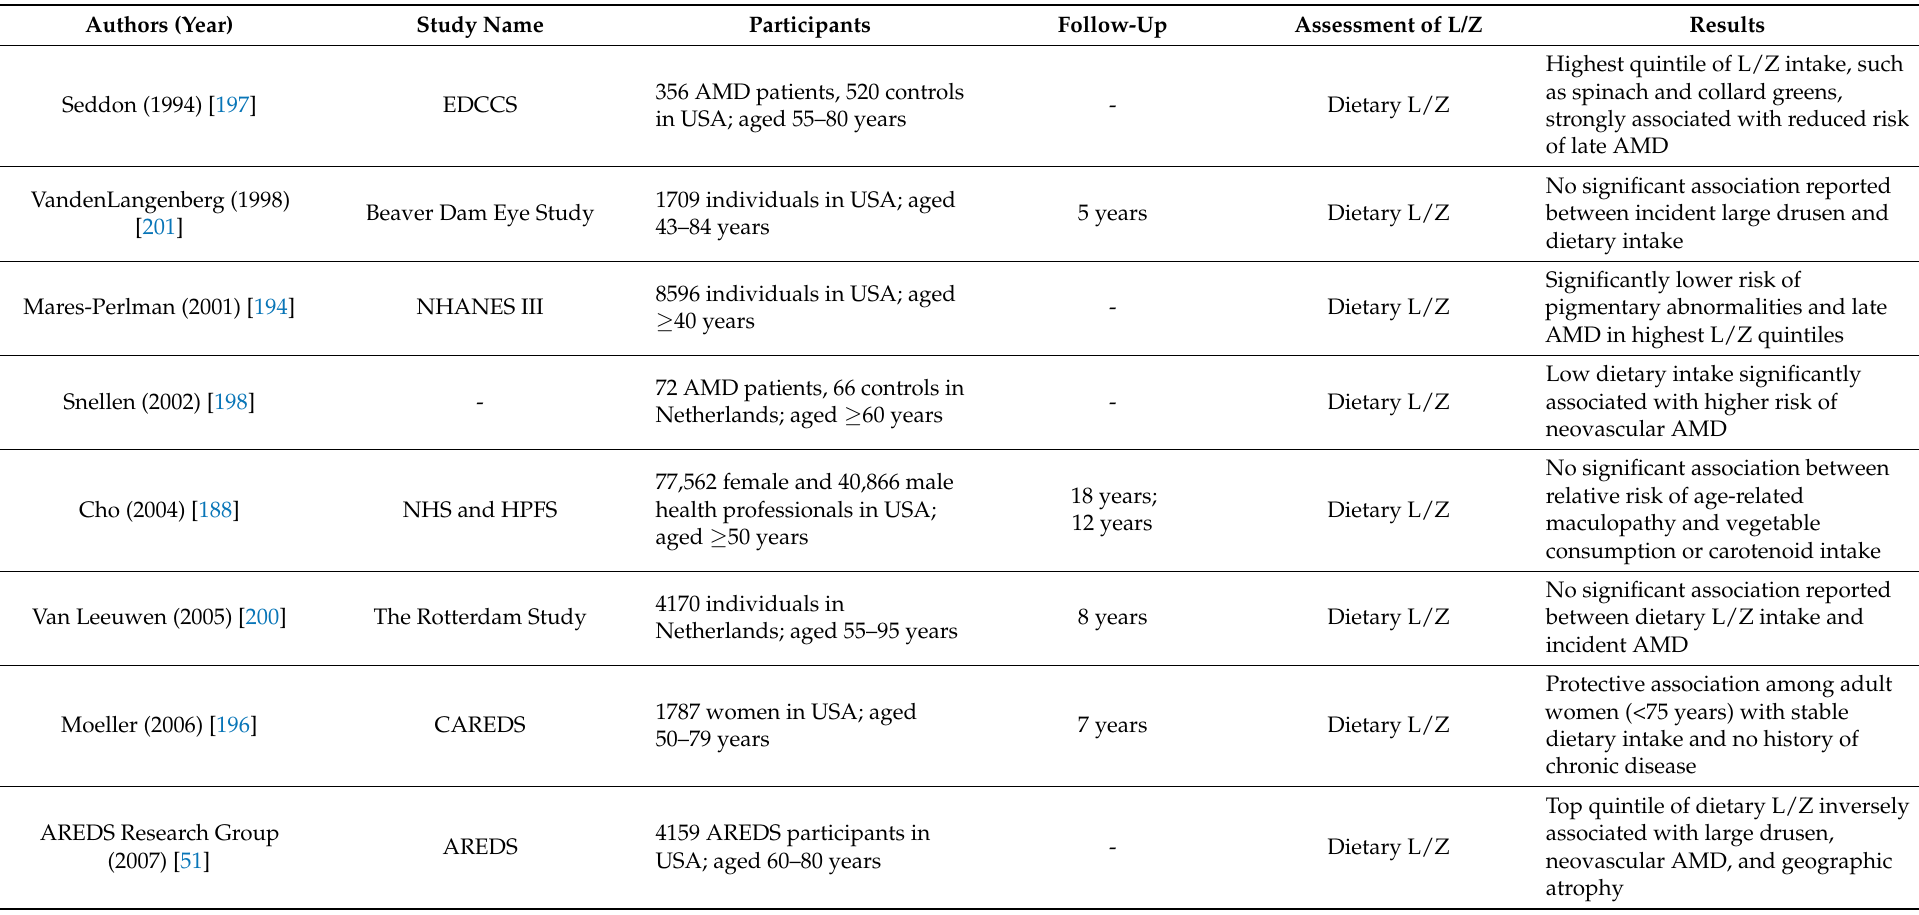
Table 3. Epidemiology studies on AMD risk associated with dietary intake and/or serum levels of lutein and